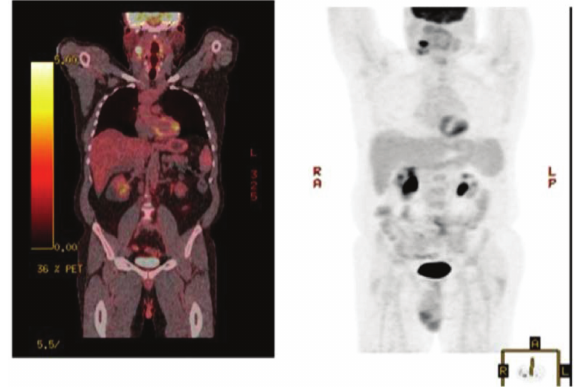
Figure 4: PET scan showing no evidence of any metastasis.